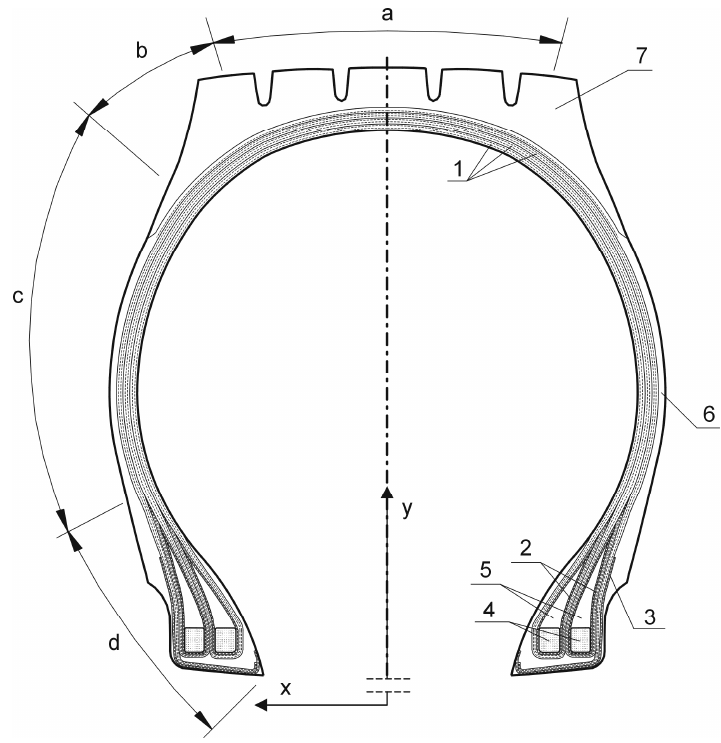
Figure 1. Meridional bias truck tire profile. a – crown, b – shoulder, c – sidewall, d – bead; 1 – 3 × ± θ doubled body plies, 2 – flipper strips, 3 – chafer, 4 – bead wires, 5 – bead fillers, 6 – sidewall, 7 – tread.